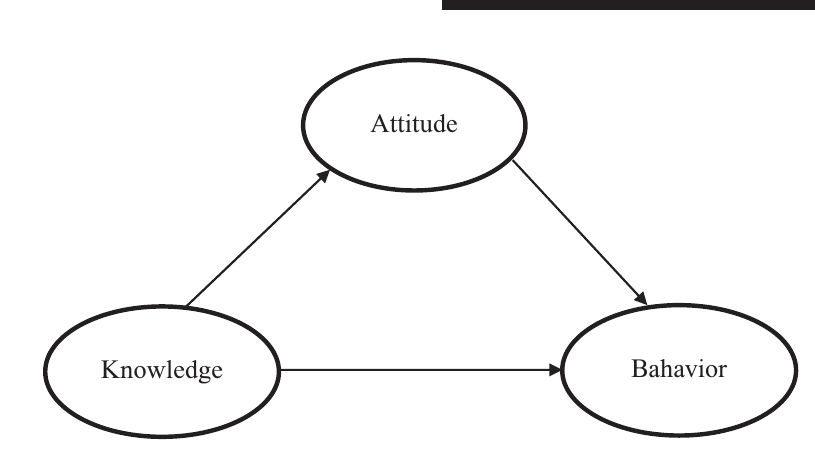
Figure 1. Health belief